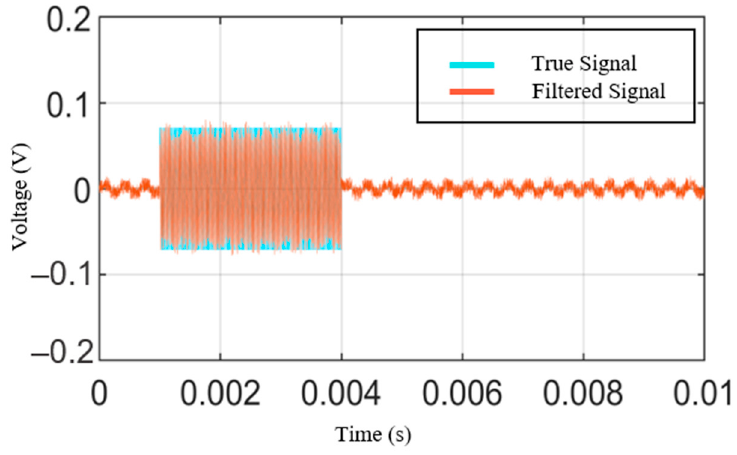
Figure 5. Simulation results of KF-RV. Table 1. Comparison of the estimation performances. Classical Kalman Filter with